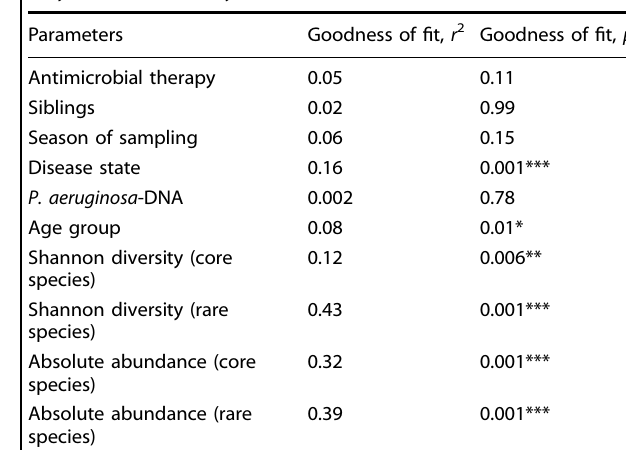
Table 2. Non-metric multidimensional scaling based on the Bray – Curtis dissimilarity matrices a